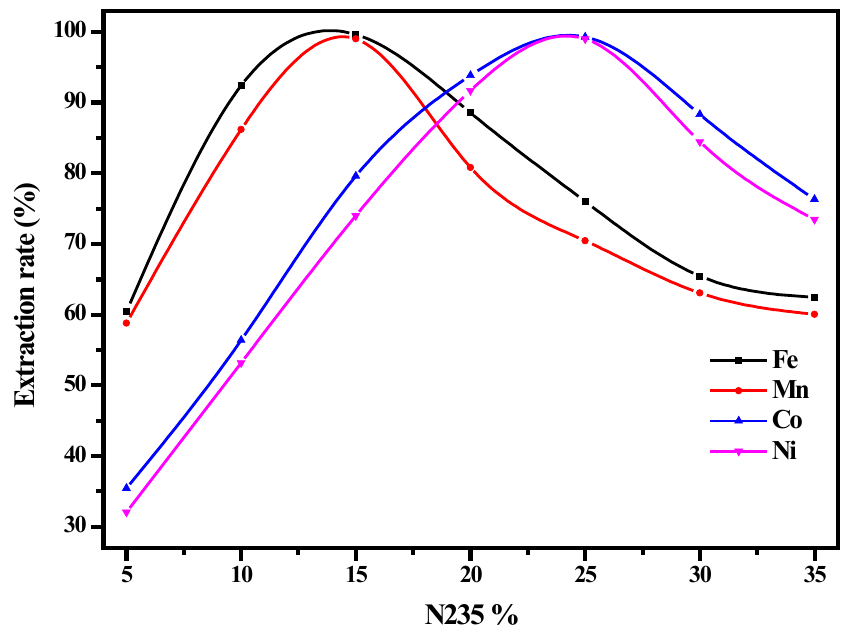
Figure 7. Effect of N235 concentration on the extraction of Fe and Mn by composite extractant.